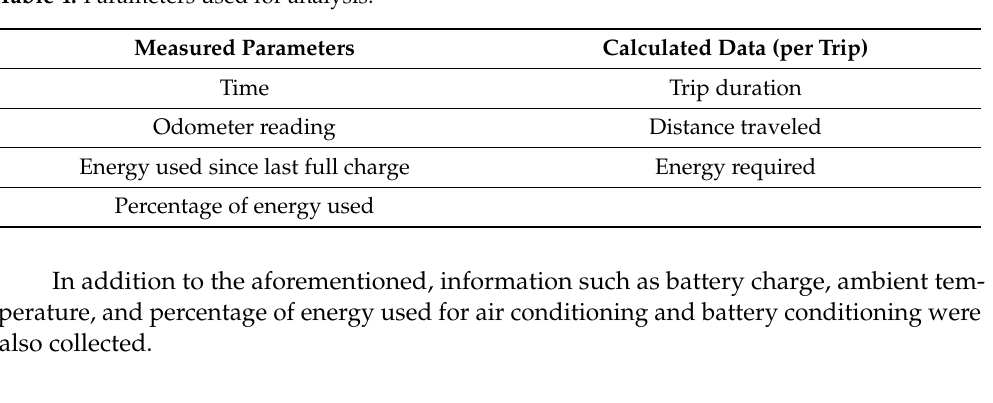
Table 4. Parameters used for